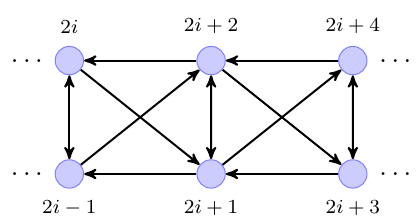
Figure 28. A portion of generic quiver of the orientifold of L 0 , 2 k, 0 / Z 2 from node 2 i